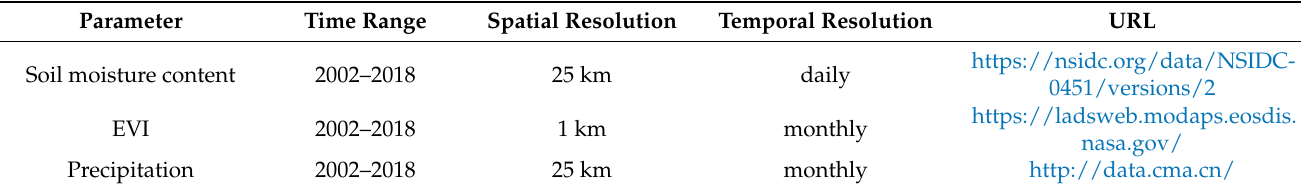
Table 1. The information of the soil moisture, EVI, and